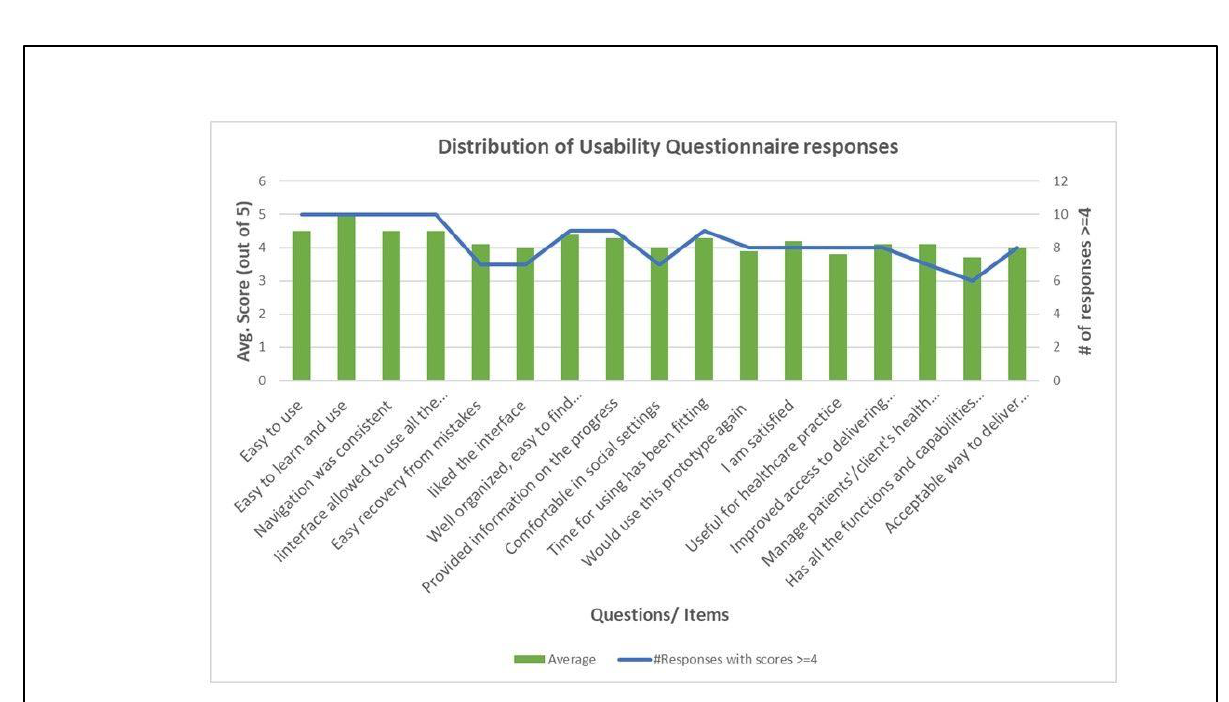
Figure 4. Distribution of responses.